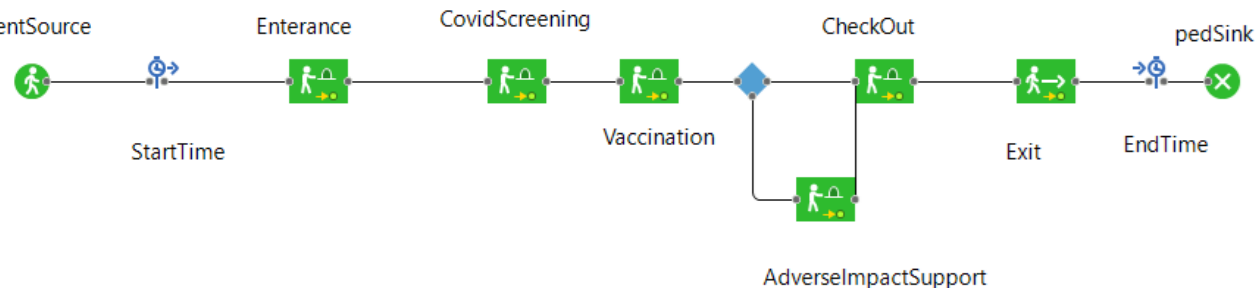
Figure 1. State chart that determines the movement of the agents through the different stages of the vaccination clinic.